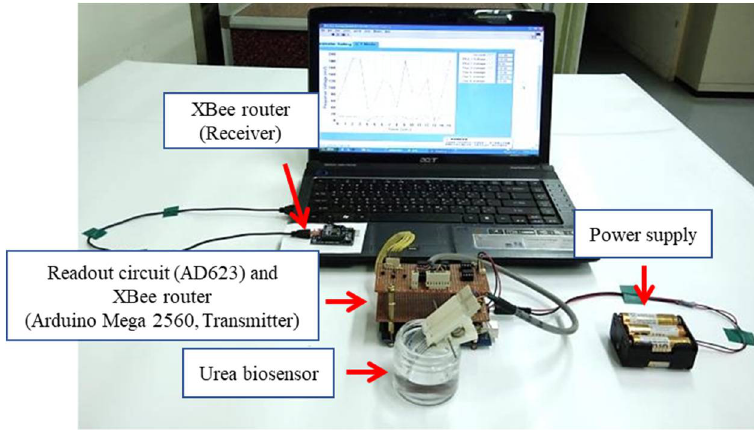
Figure 3. The photo of the wireless measurement system.